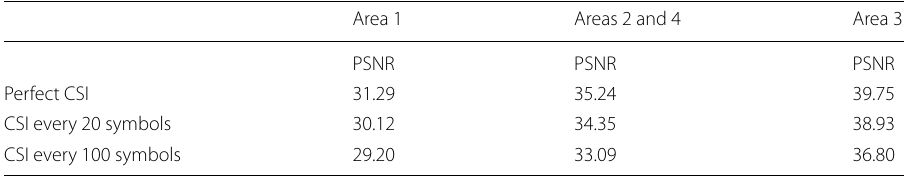
Table 12 Average performance of the Monarch image for different CSI